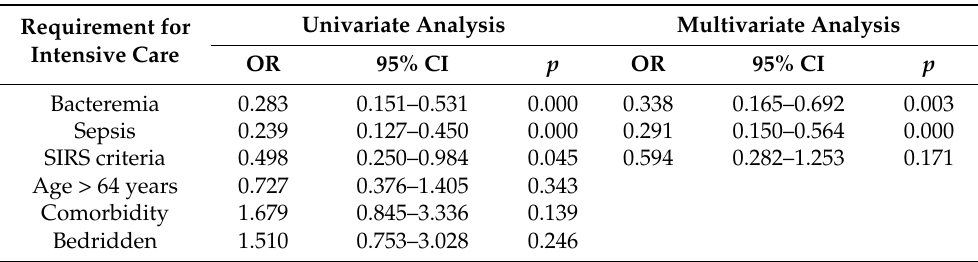
Table 2. Bacteremia and sepsis are two independent factors associated with the requirement for intensive care in adult patients with UTI.